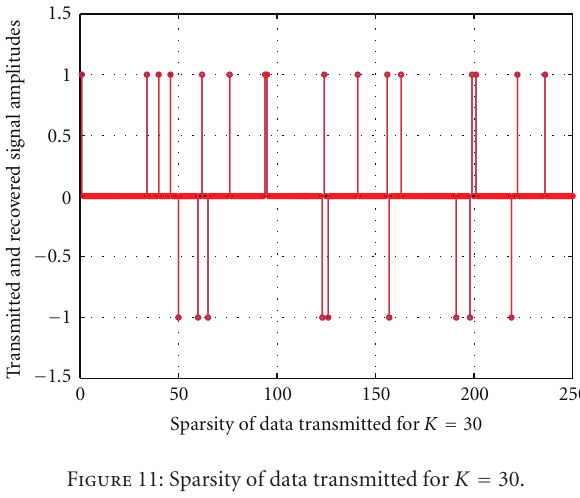
Figure 11: Sparsity of data transmitted for K = 30.